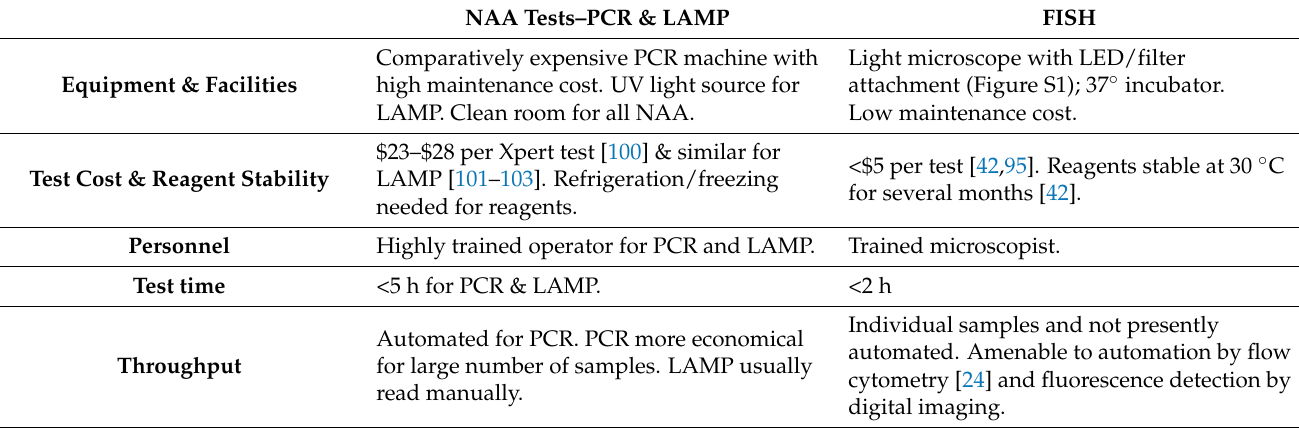
Table 2. Comparison of two NAA and FISH tests for malaria and